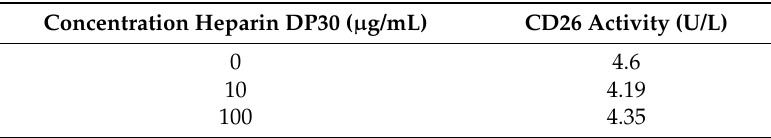
Table 1. Effect of heparin on the proteolytic activity of